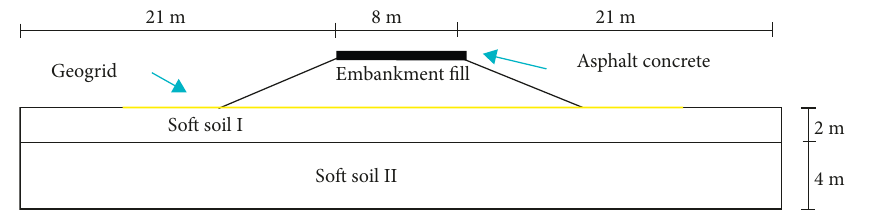
Figure 1: Modeled geometry of the unreinforced embankment.